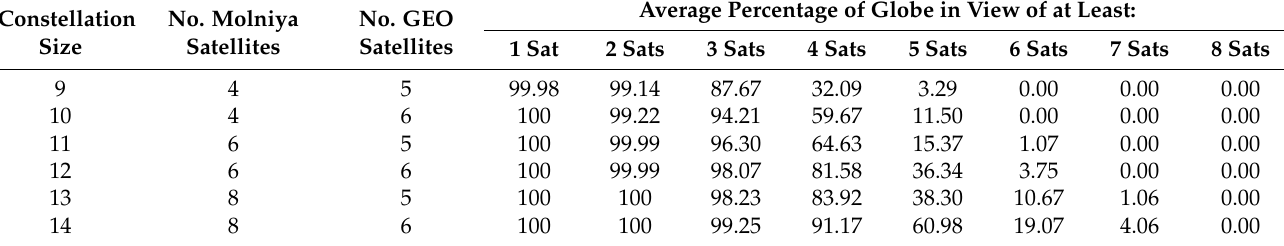
Table 6. Average global percentage of multi-view